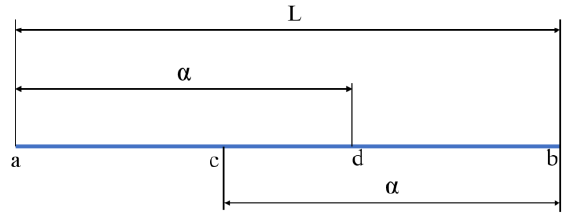
Figure 6. Interval division of the golden section method.